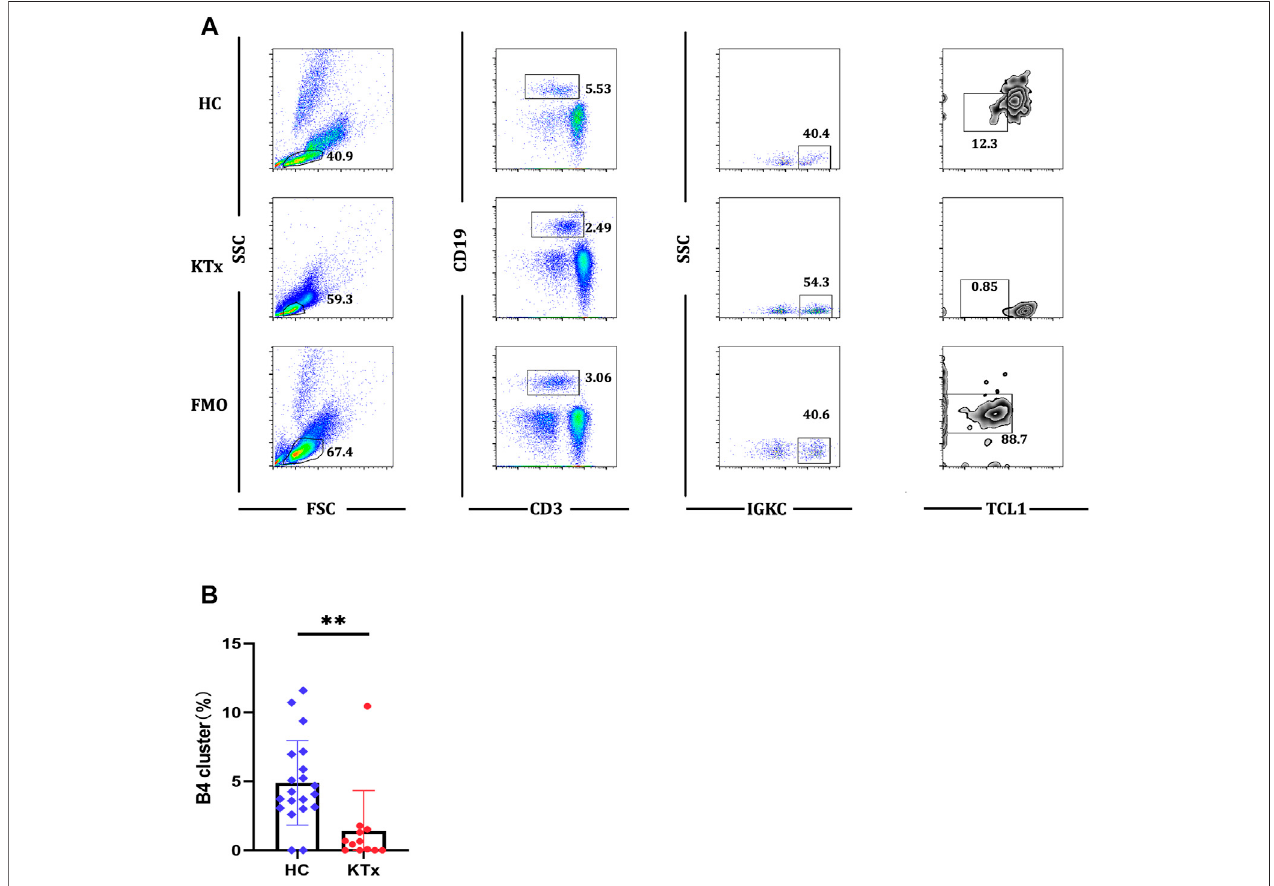
FIGURE 6 | Flow cytometric analysis of B4 cluster in HC and KTx groups. (A) Gating strategy and fl ow cytometric plots of B4 cluster in HC, KTx, and FMO control groups. (B) Frequency of CD19 + IGKC + IGLC - B4 cluster from CD19 + B cells in HC and KTx groups. A Mann – Whitney test was used to analyze the differences between two groups. ** p <